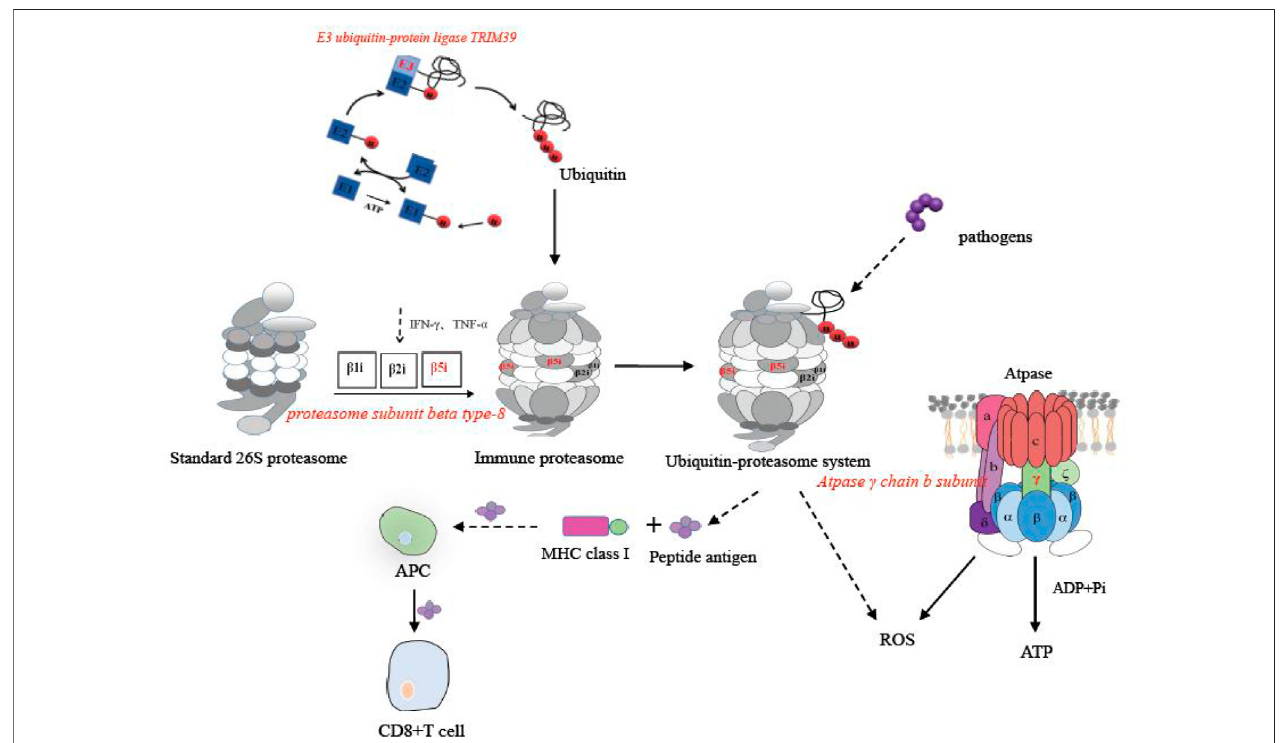
FIGURE 5 | Immune pathways of PSMB8 , E3 ubiquitin-protein ligase TRIM39-like , and ATP synthase F(0 ) complex subunit B1 in the O. niloticus intestine.